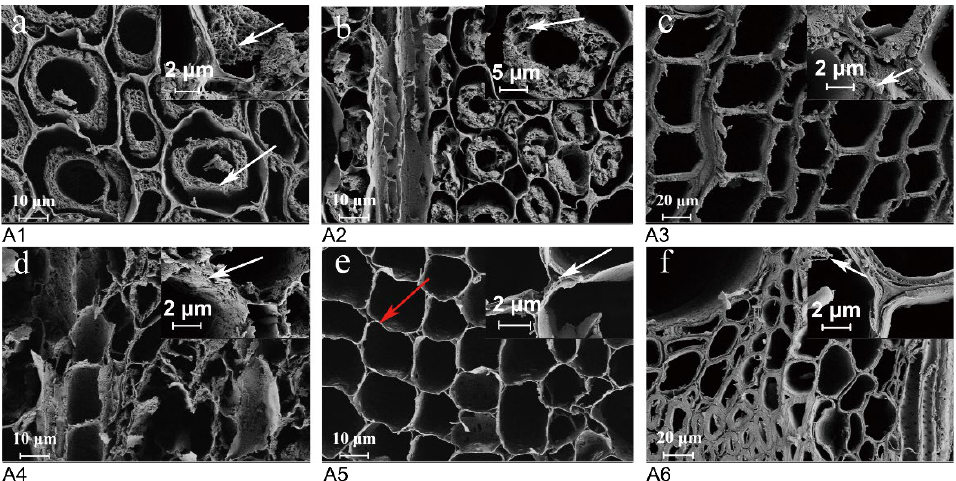
Figure 4. Scanning electron micrographs of waterlogged archaeological wood (( a ), mason pine; ( b ), sweet gum; ( c ), fir; ( d ), persimmon; ( e ), banyan; ( f ), teak).